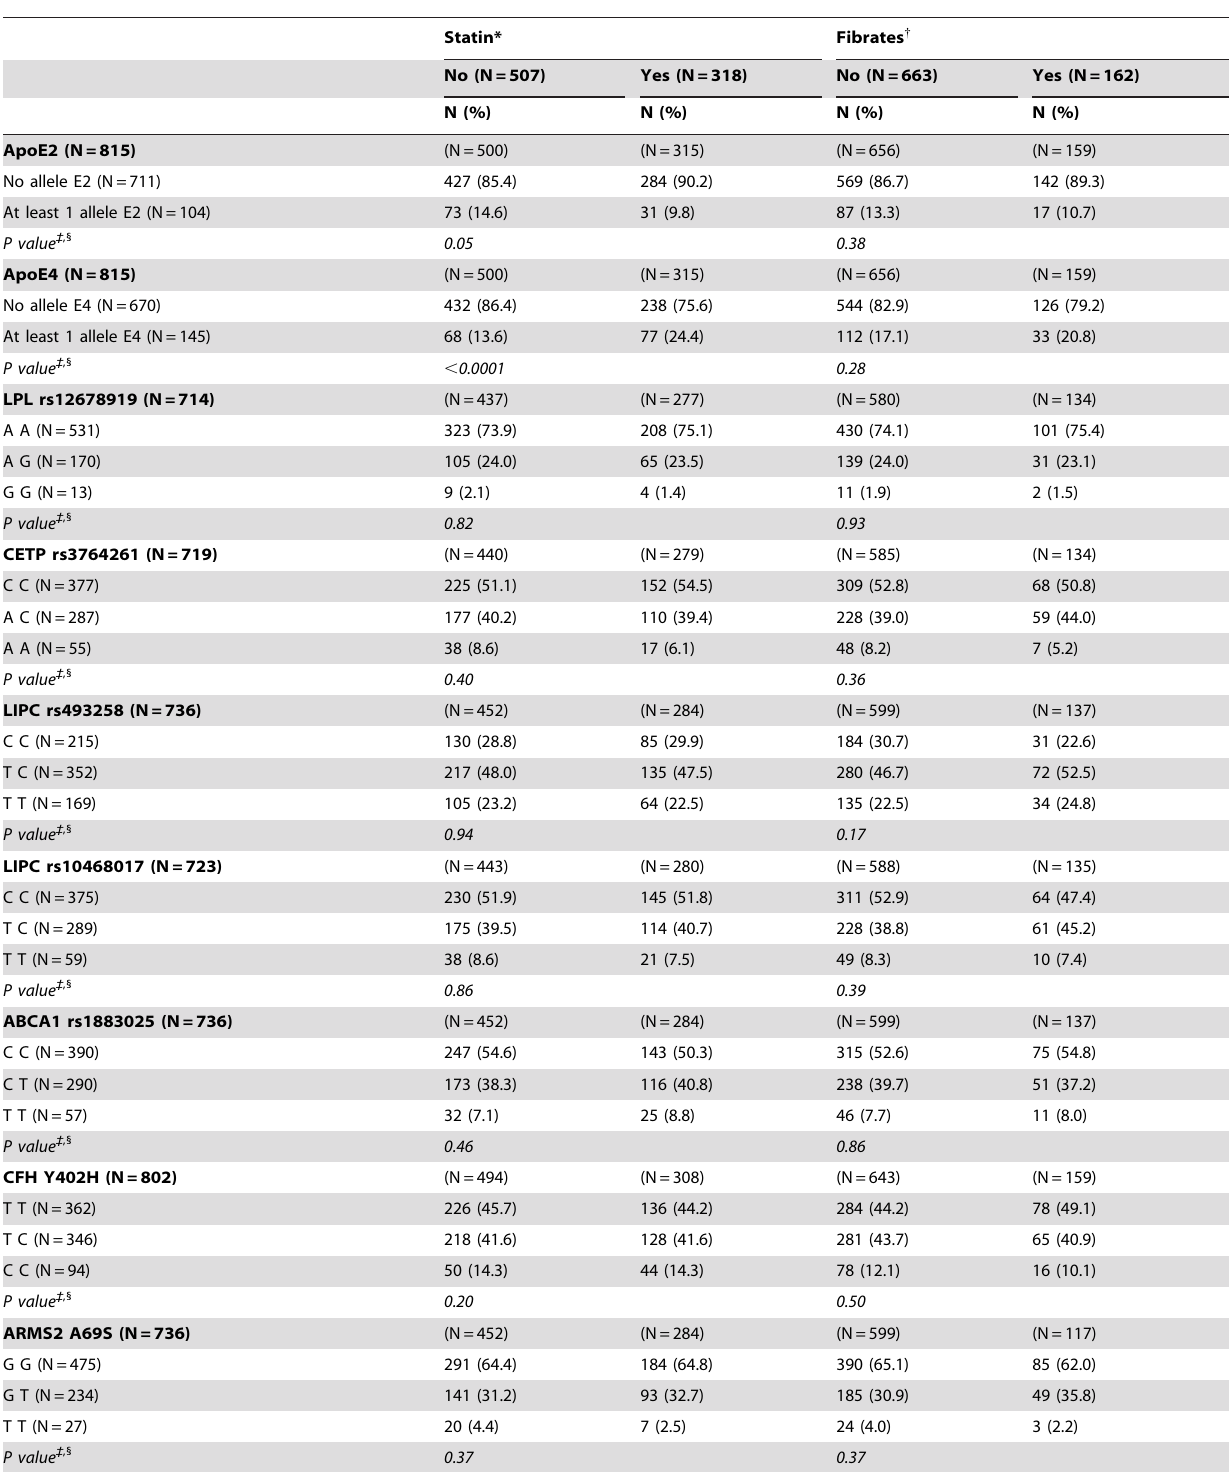
Table 3. Statin and fibrate drug use according to genetic characteristics in subjects of the Alienor study (N= 825).